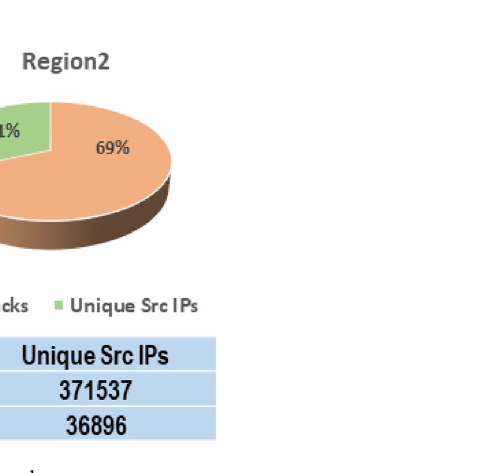
Figure 7. Unique source IP count by the Ddospot